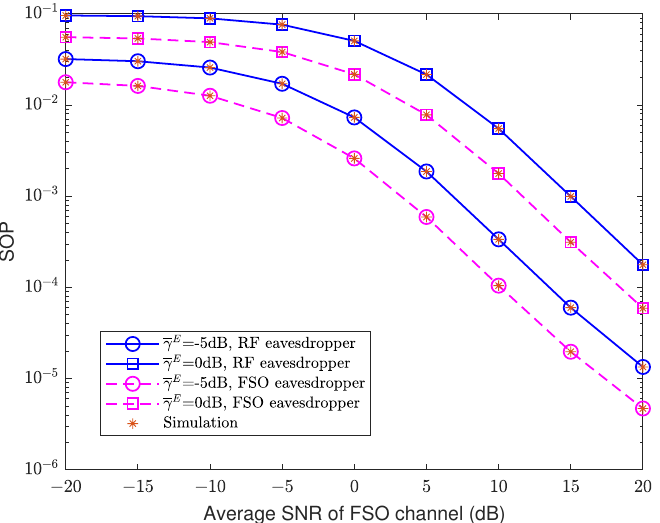
Figure 7. Under different γ E conditions, the relationship between the SOP of the hybrid system with RF and FSO link eavesdropping and the average SNR of the FSO